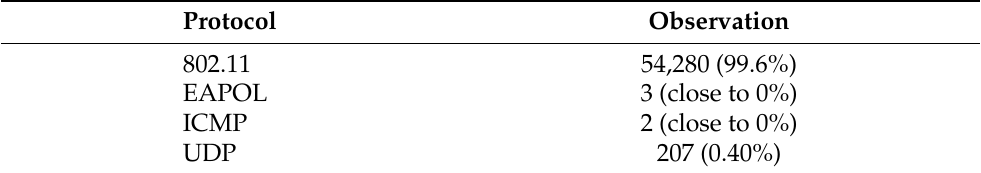
Table 4. ECU-IoFT Dataset–Protocol distribution.